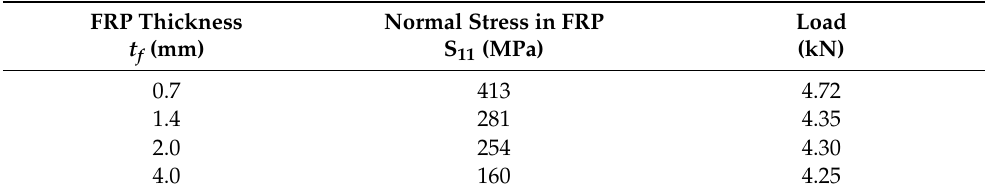
Table 3. Normal stress of CFRP sheets at concrete and tensile failure load for different CFRP thick- ness.